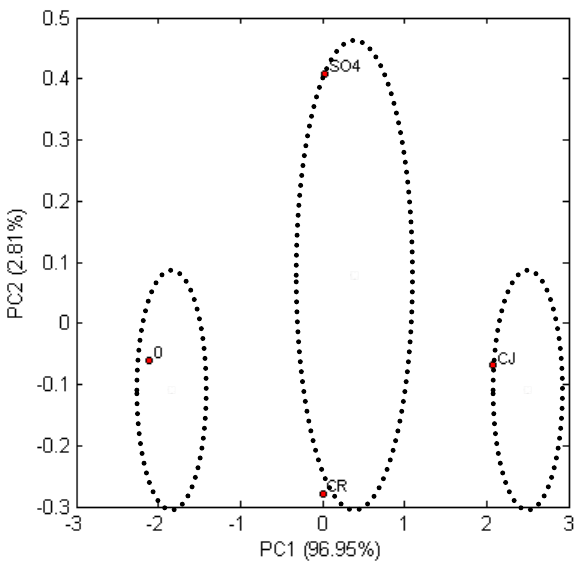
Figure 6. PCA scores plot of triticale straw pretreatment by ionic liquid, recycled ionic liquid or sulfate method, untreated (control).